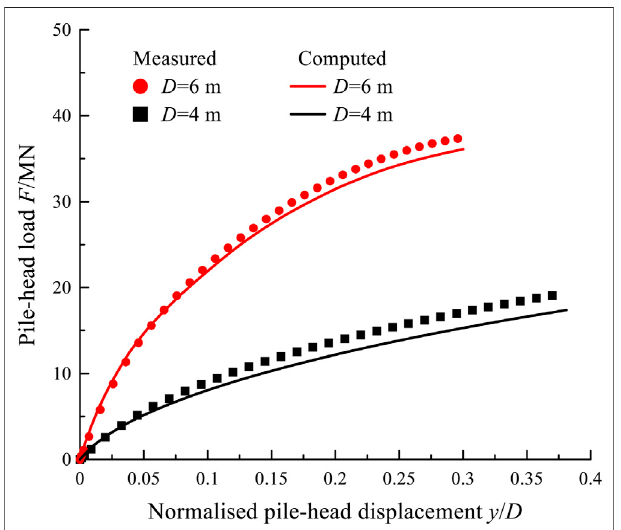
FIGURE 8 | Model validation against centrifuge test performed by Lai et al. [5].